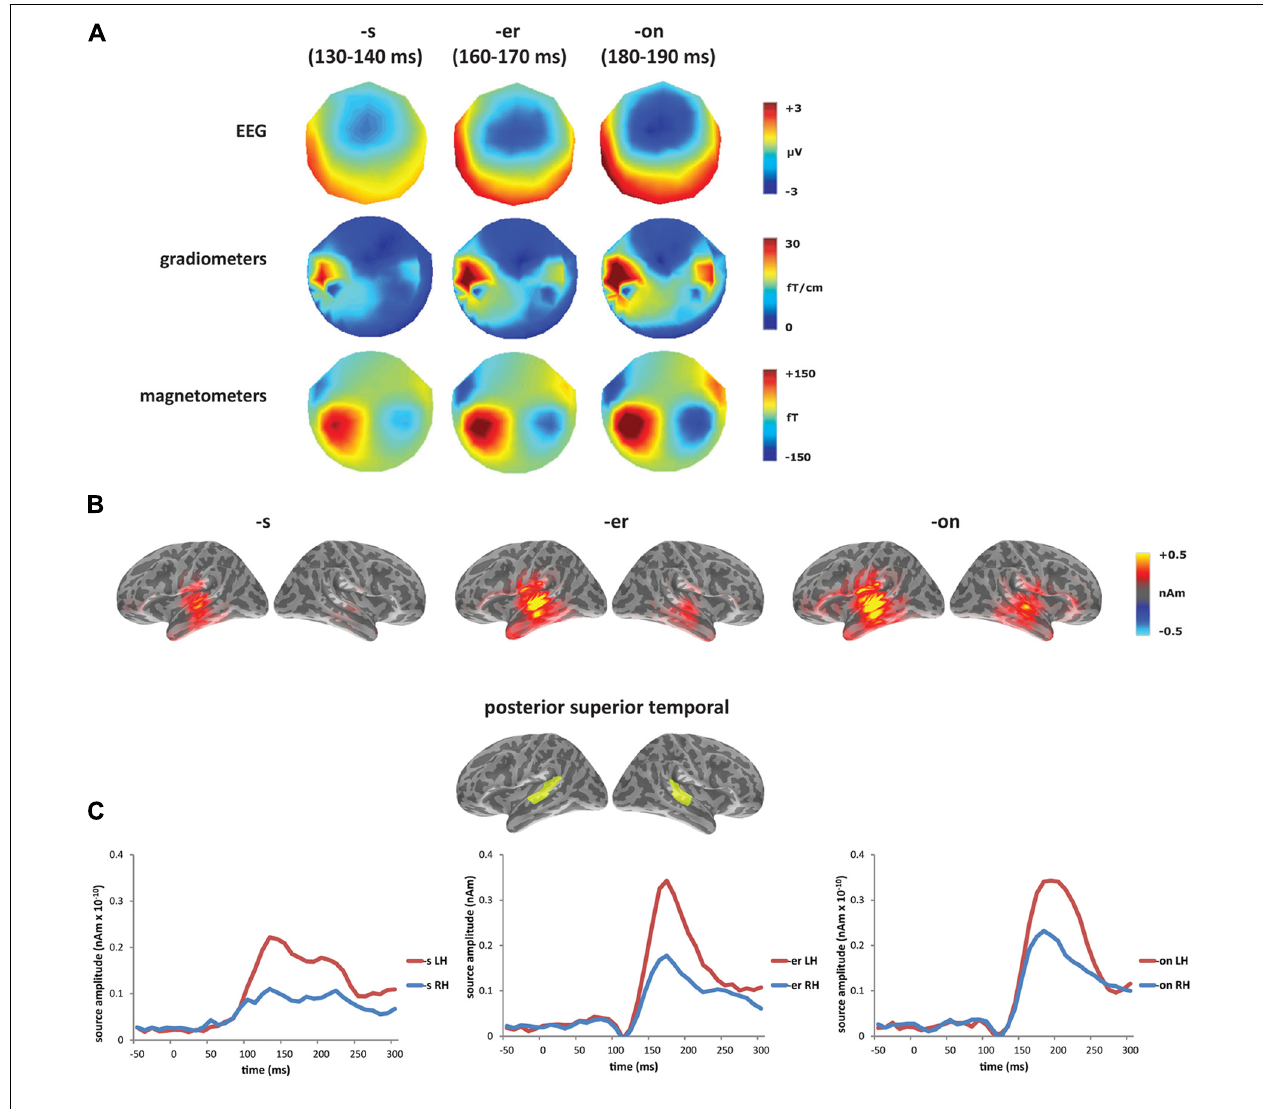
for [-s] deviant (130–140 ms), [-er] deviant (160–170 ms), and [-on] deviant (180–190 ms). (C) Time course of source-level activity in left and right posterior superior temporal gyrus for three deviant